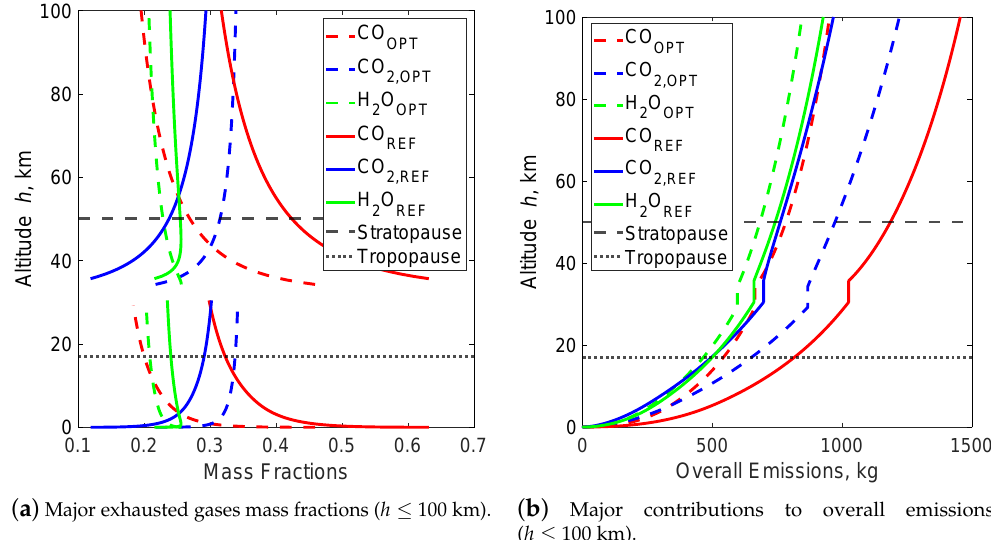
Figure 8. Comparison of the major mass fractions of the considered exhausted gases and overall emissions: REF vs.